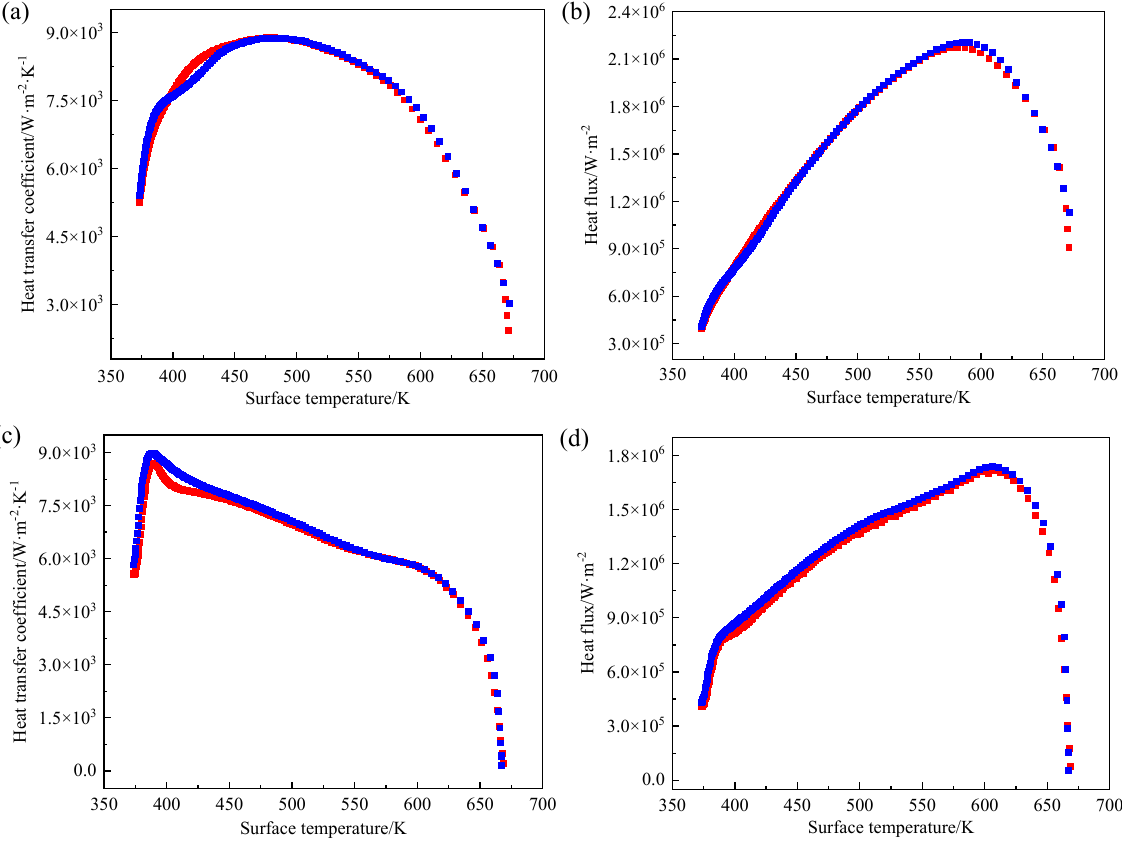
Figure 4. Comparison of boiling curves under the same condition, including HTC and heat flux in impingement zone ( a , b ) and free - falling zone ( c , d ).